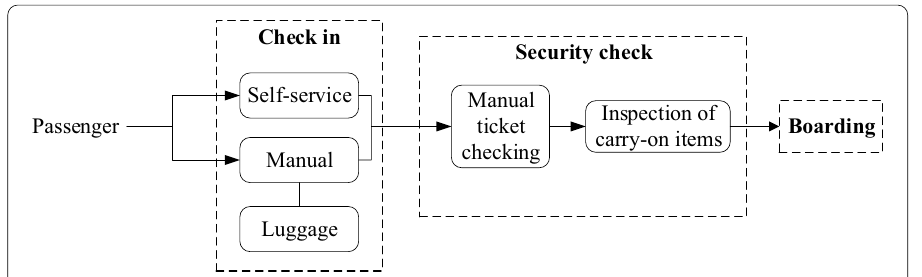
Fig. 1 Routine procedures of passenger check-in, security check and boarding; instructions for passenger boarding procedures, from left to right, the first dashed box is the check in process, the second dashed box is the security check process, and the third dashed box is the boarding process